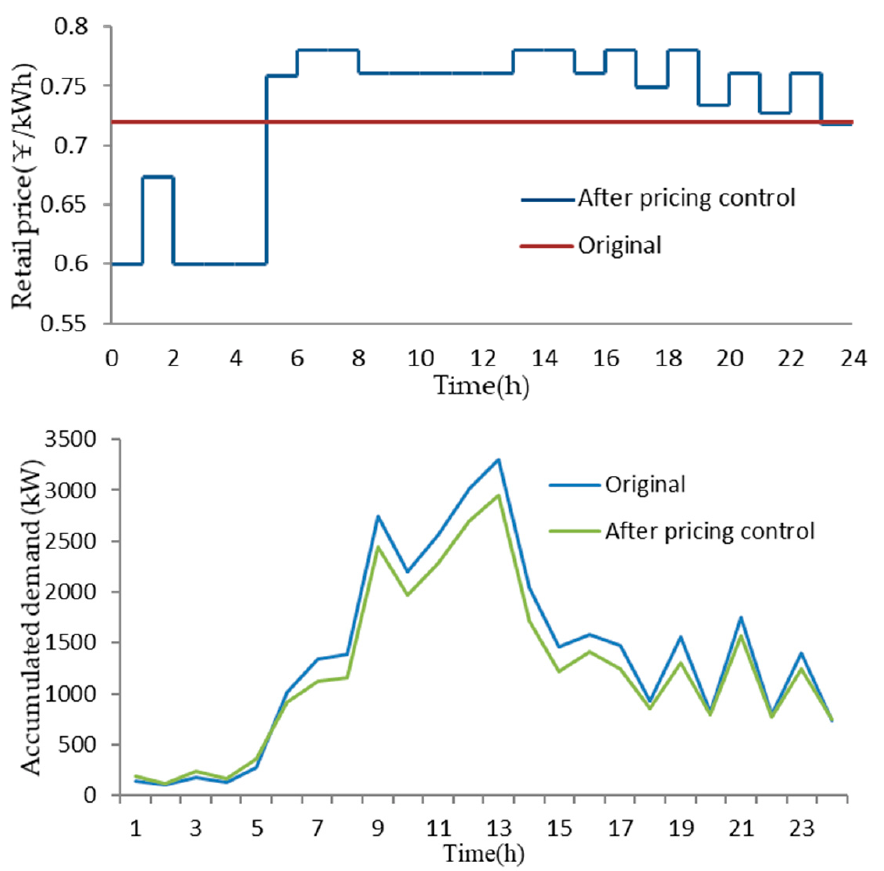
Figure 9. Correlation of retail price and accumulated demand.